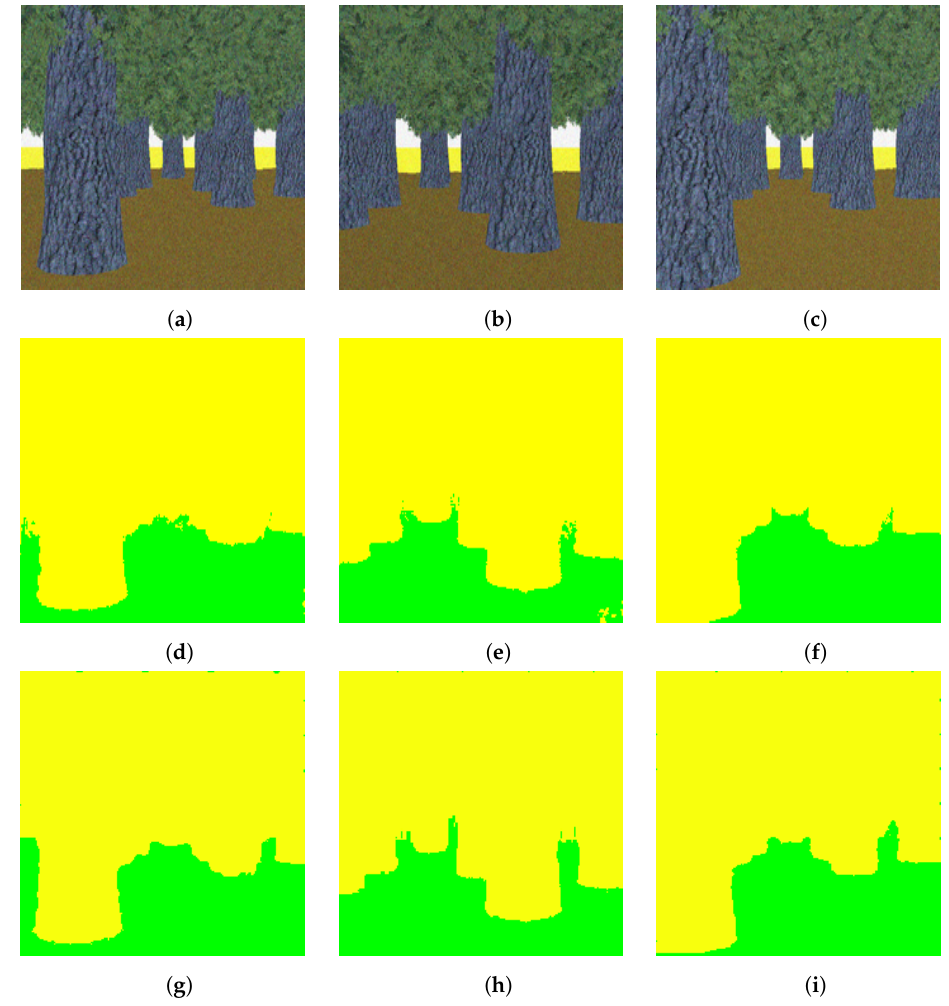
Figure 7. Segmentation of the two-class synthetic dataset ( a – c ): test images, ( d – f ): corresponding segmented images using DeconvNet, ( g – i ): corresponding segmented images using the proposed light-weight network. Note that the color code for classes is: yellow: tree, green: ground. Best viewed in